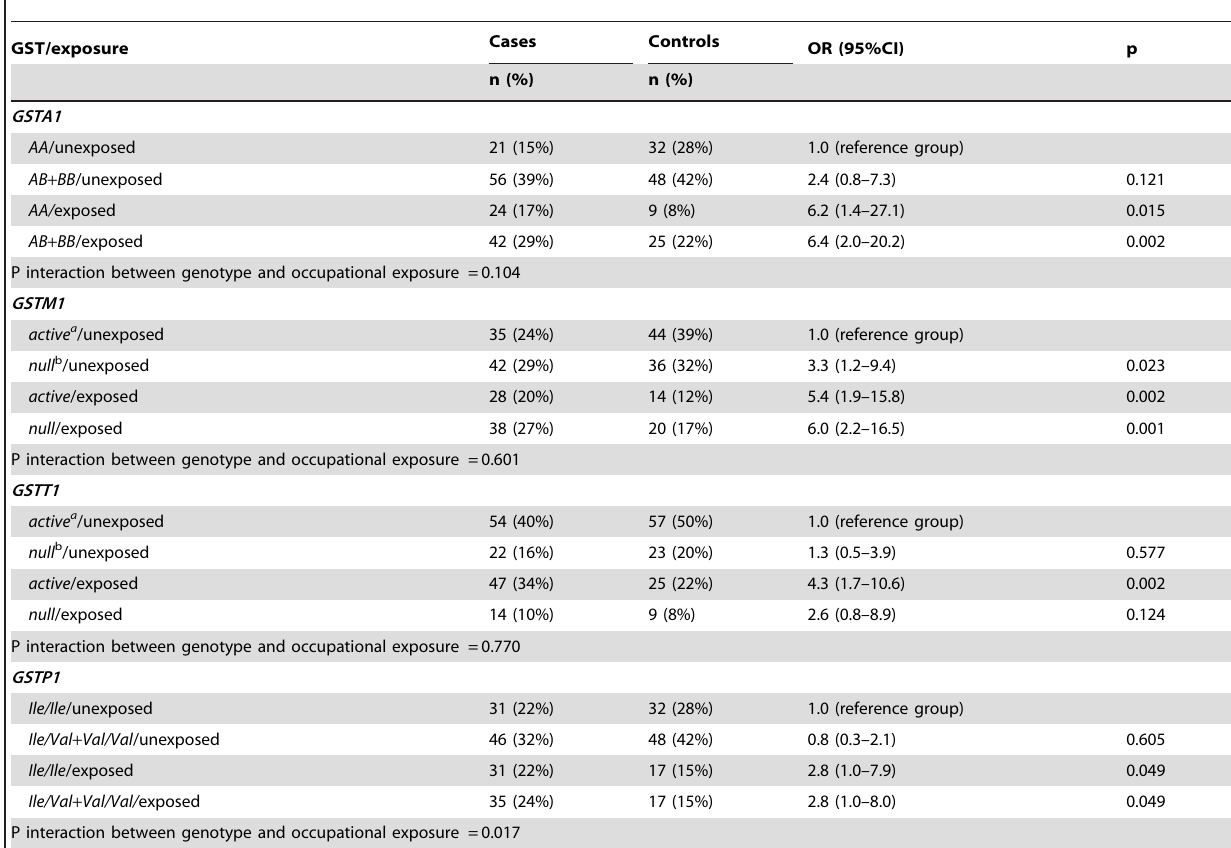
Table 3. Combined effect of occupational exposure and GST genotype on bladder cancer risk in male male